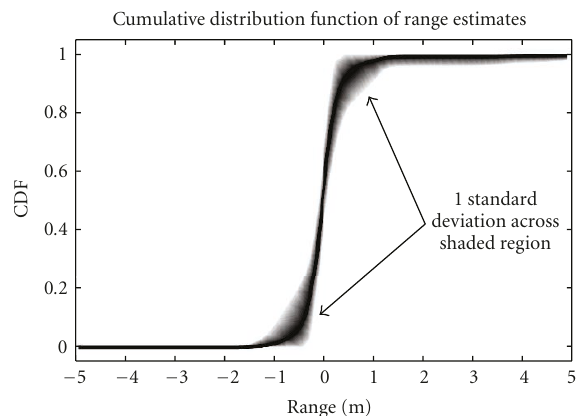
Figure 11: Cumulative distribution functions of all zero-mean range estimates.